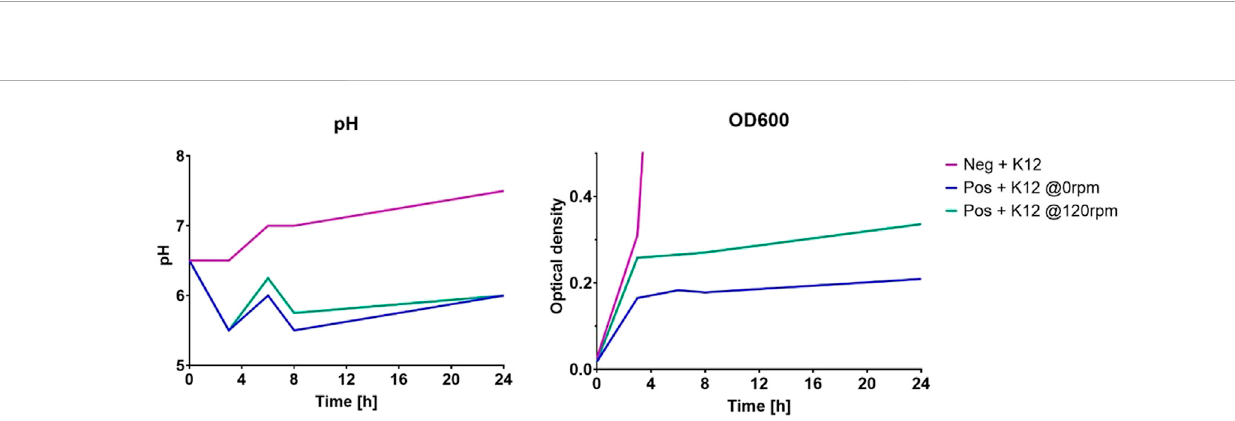
FIGURE 2 Depiction of pH and OD 600 propagation over the course of the fi rst experimental run.